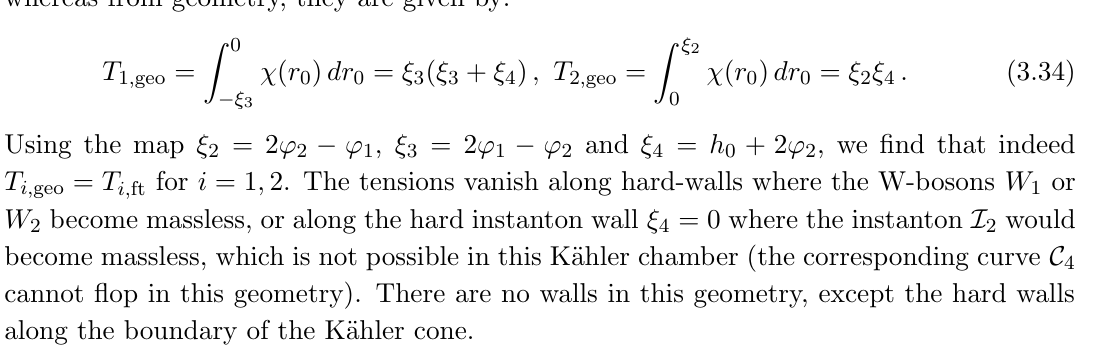
Figure 9 . The two resolutions of the E 12 ; 0 singularity. Resolution (a) admits a vertical reduction. whereas from geometry, they are given